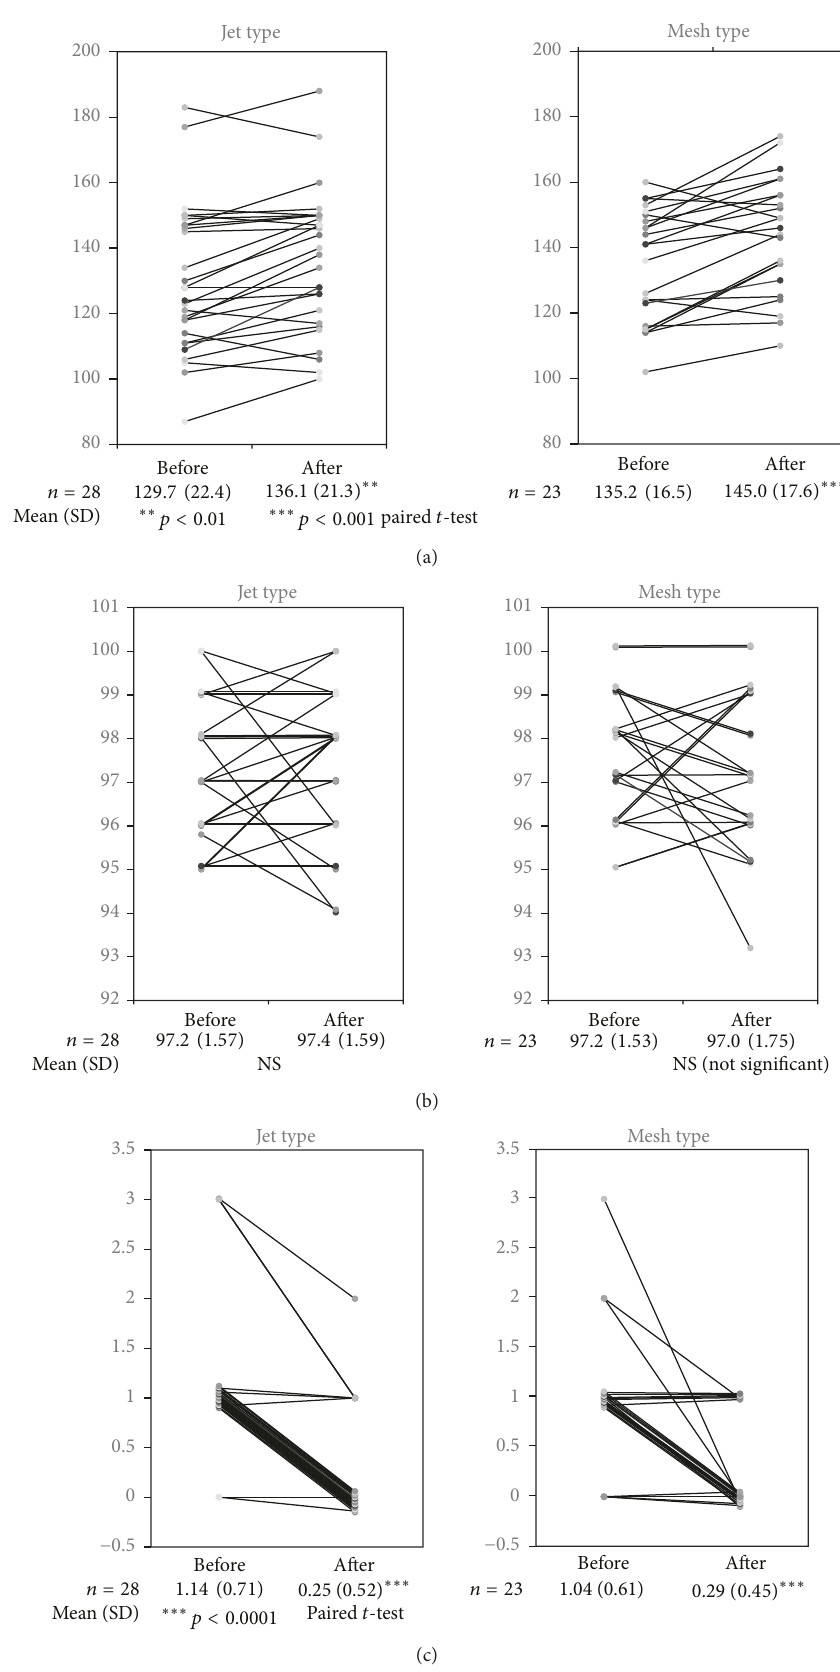
Figure 1: Changes in children ≥ 2 years old. (a) Changes in heart rate. (b) Changes in SpO2. (c) Changes in symptom